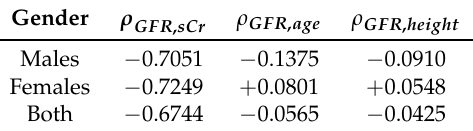
Table 2. Sample correlation coefficients between glomerular filtration rate and age, height and creatinine concentration levels from pedriatic patients’ data. Serum creatinine concentration refers to the IMDS-traceable